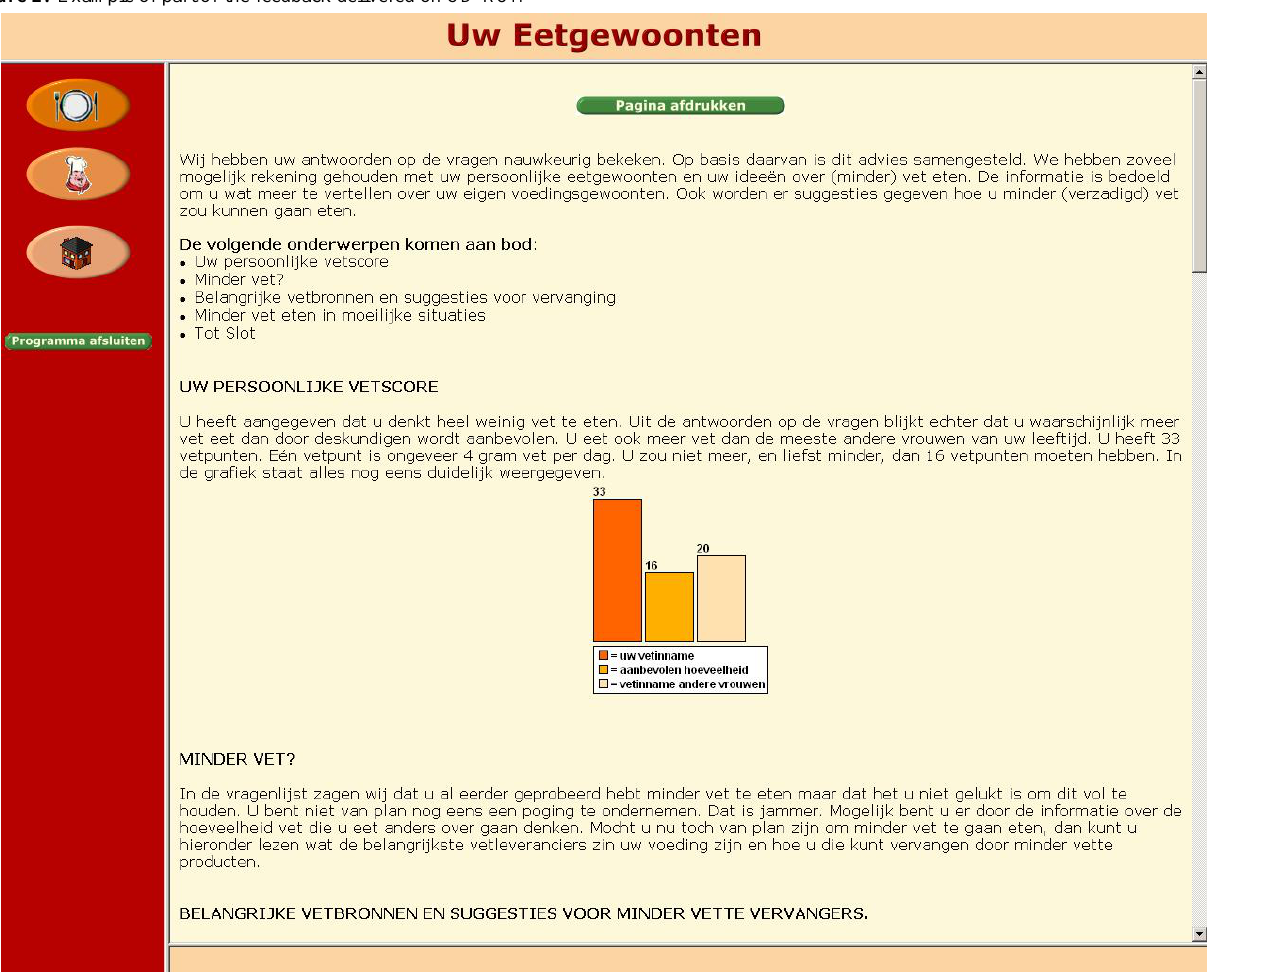
Figure 2. Example of part of the feedback delivered on